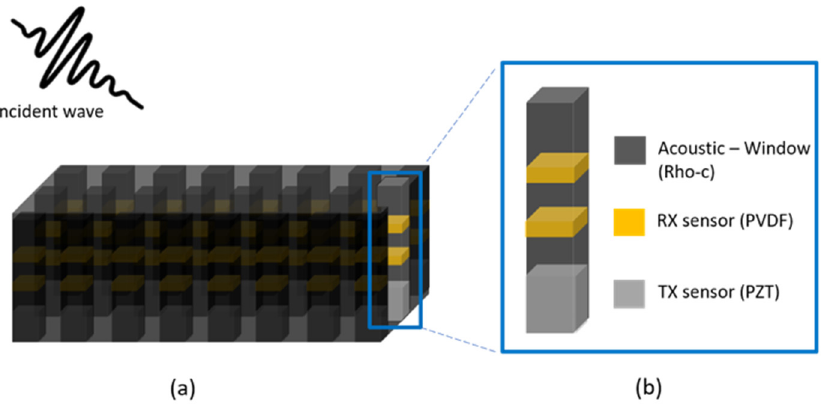
Figure 1. Concept of the transducer: ( a ) array type; ( b ) single